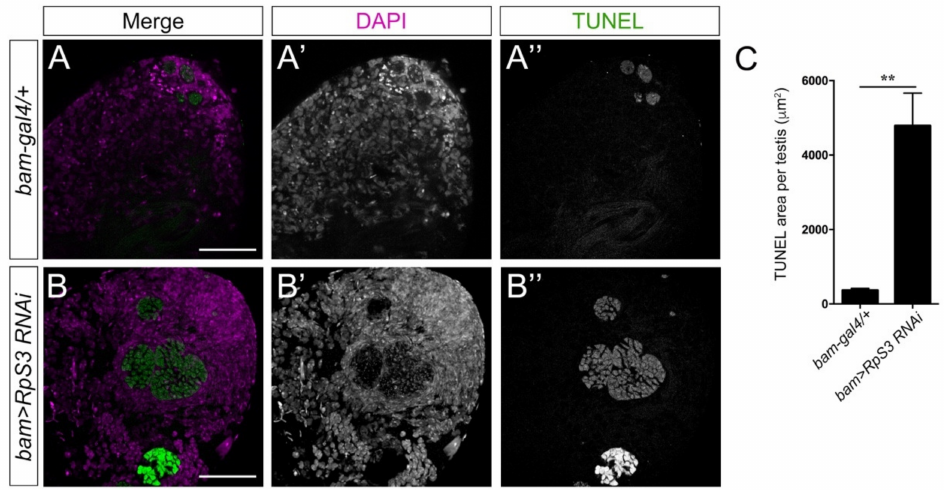
Figure 6. Knockdown of RpS3 induces apoptosis in the testes. ( A , B ) The TUNEL (green) signal at the apical region of the testes with indicated genotypes. DAPI (magenta) stained the nuclei. The single channel images for DAPI staining were shown in ( A’ , B’ ); the single channel images for TUNEL staining were shown in ( A” , B” ). ( C ) The area with TUNEL signals in control ( n = 14) or RpS3 -knockdown testes ( n = 16) was measured and quantified. ** p < 0.01. Scale bars: 25 µ